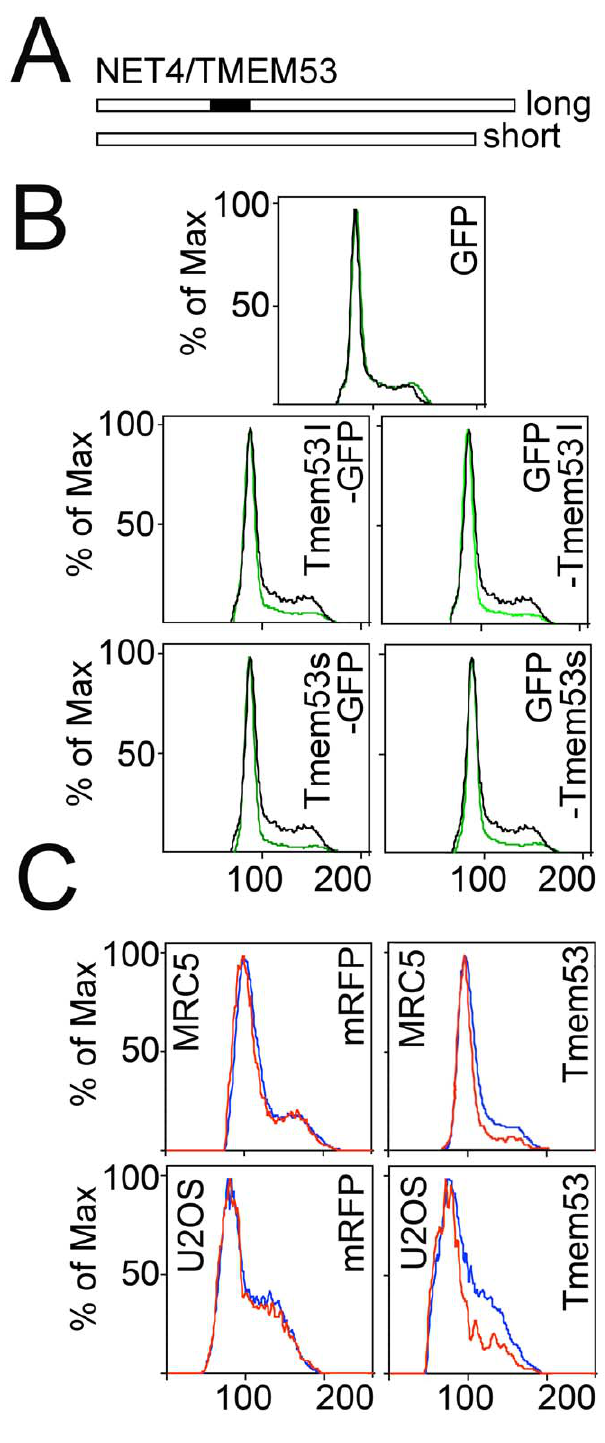
Figure 5. Splice variants of NET4/TMEM53 and the effect of knockdown in U2OS and MRC5 cells. (A) Two splice variants of NET4/TMEM53 were cloned that differed only by a 33 amino acid insertion roughly a third of the way into the protein. (B) Both long (l) and short (s) splice variants had the same effect on cell cycle/DNA content profiles and effects were independent of whether the GFP tag was on the amino terminus or carboxyl terminus. (C) Because siRNAs failed to knock down NET4/TMEM53 in HEK293T cells, the cell cycle/DNA content profile effect of the original NET4/TMEM53-mRFP construct was tested on U2OS and MRC5 cells as alternatives for knockdowns.